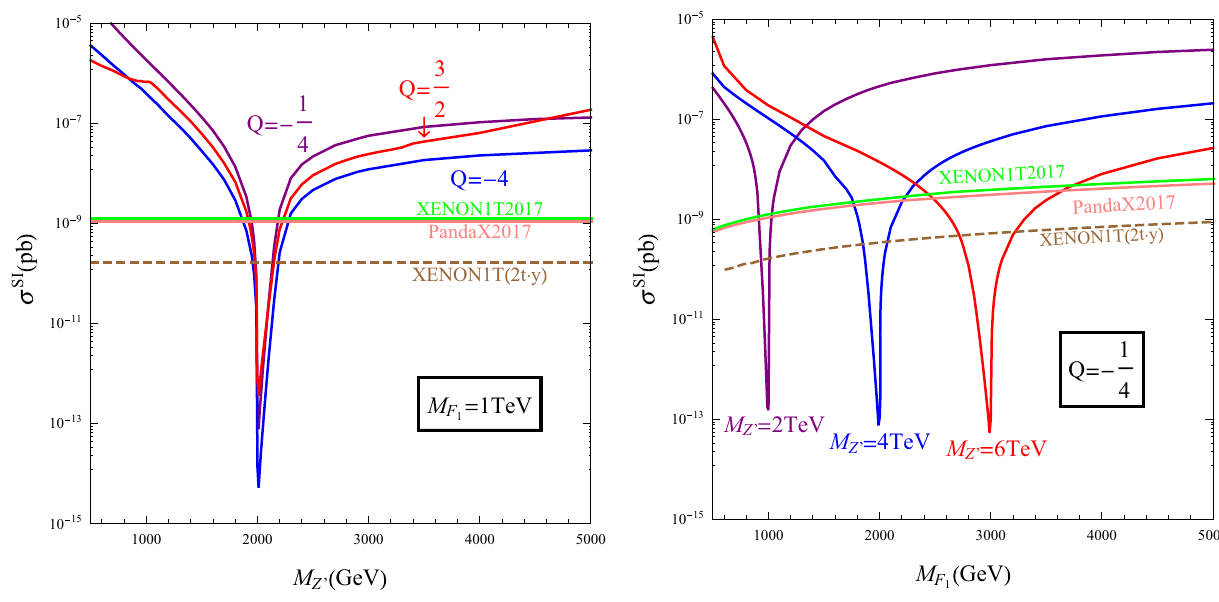
Fig. 9 Same as Fig. 8, but for fermion DM F 1 and spin-independent DM-nucleon scattering (see Eq. 23), ( | V | = 1 ) corresponds to the smallest B − L charge. Q = 3 F 1 2 4 density, leading to largest scattering cross